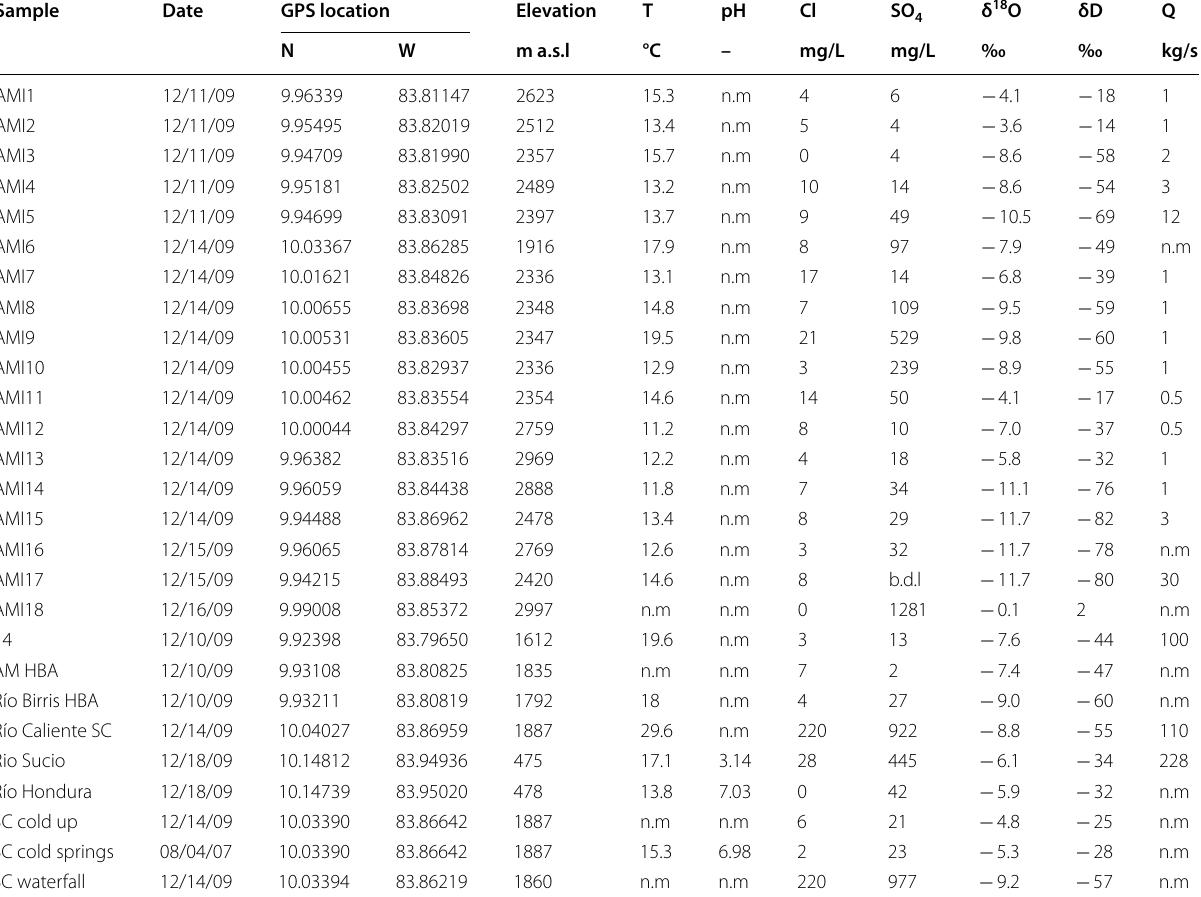
) and isotope values of meteoric waters (AM), rivers and cold springs for Irazú (I) 4